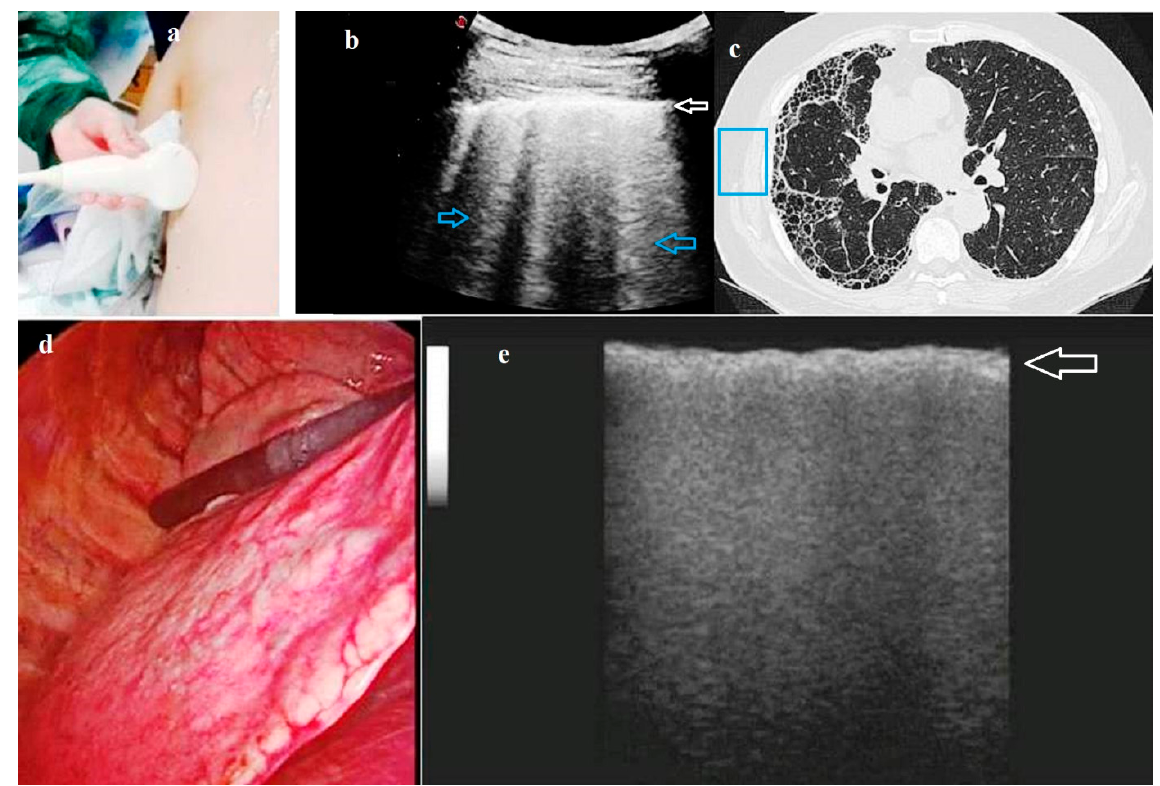
Figure 4. A case of Usual Interstitial Pneumonia (UIP) fibrosis (histological diagnosis). ( a ) Photograph taken during the pre-operatory Transthoracic Ultrasound (TUS) examination showing a multi-frequency convex probe (2–8 MHz) placed on the posterior chest wall. ( b ) Pre-operatory TUS scan (convex probe, 5 MHz) showing an increased thickness of the hyperechoic pleural line (white arrow) and an increased number of B lines below it (blue arrows). ( c ) High-Resolution Computed Tomography (HRCT) scan of the same patient showing a pattern of fibrosis. The blue box enhances the area corresponding to the TUS scan showed in b). ( d ) Image of the pulmonary parenchyma during video-assisted thoracoscopic surgery (VATS). ( e ) Intraoperatory lung ultrasound (ILU) scan (linear probe, 12 MHz) showing an irregular thickening (white arrow) of the interface line between lung and the ultrasound probe (i.e., the intraoperatory “pleural line”) with no artifact below it.